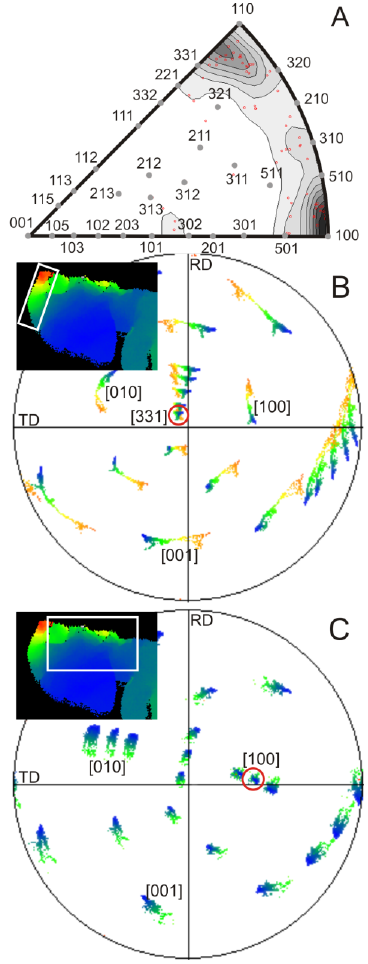
Figure 11. Orientation and misorientation data of grain IV12- 06C_05, lattice distortion type (II). (a) Inverse pole figure plot of the misorientation axes distribution density, showing axes concen- trated parallel to [331] and [100] axes. (b) and (c) show pole figure plot showing crystal directions (lower-hemisphere equal area pro- jection) of two deformed parts of the grain (indicated by a white rectangle in the inset), colored as in insets. Misorientation axes are highlighted by the red